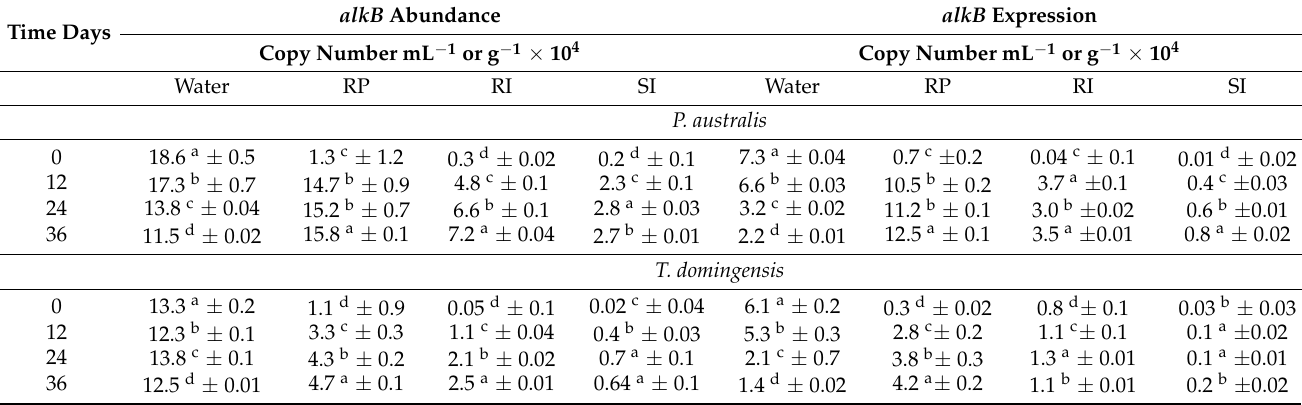
Figure 3. Transmission electron micrographs of bacterial communities associated with Phragmites australis : ( A ) in the rhizoplane; ( B ) inside root cells; ( C ) in intracellular space of the root. B = bacteria; CW = plant cell wall; ICS = intercellular space; N = nucleus. Table 4. Abundance and expression of alkB in the water, rhizoplane (RP), root interior (RI), and shoot interior (SI) of Phragmites australis and Typha domingensis in FTWs.